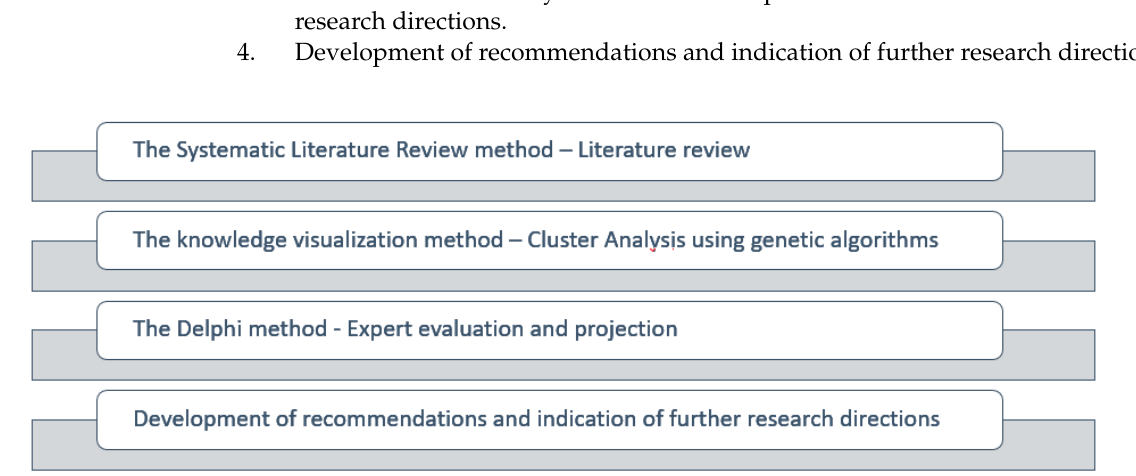
Figure 1. Research steps to carry out the study.